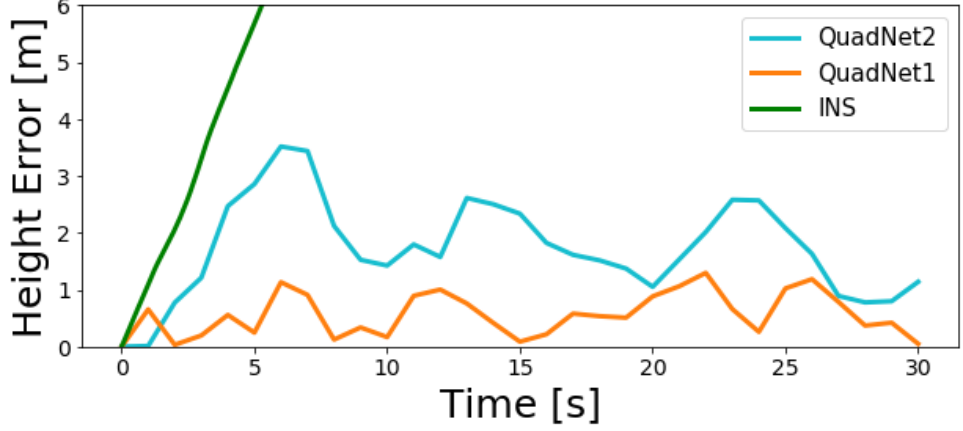
Figure 11. INS, QuadNet2, and QuadNet1 calculated height error throughout the trajectory for the second test